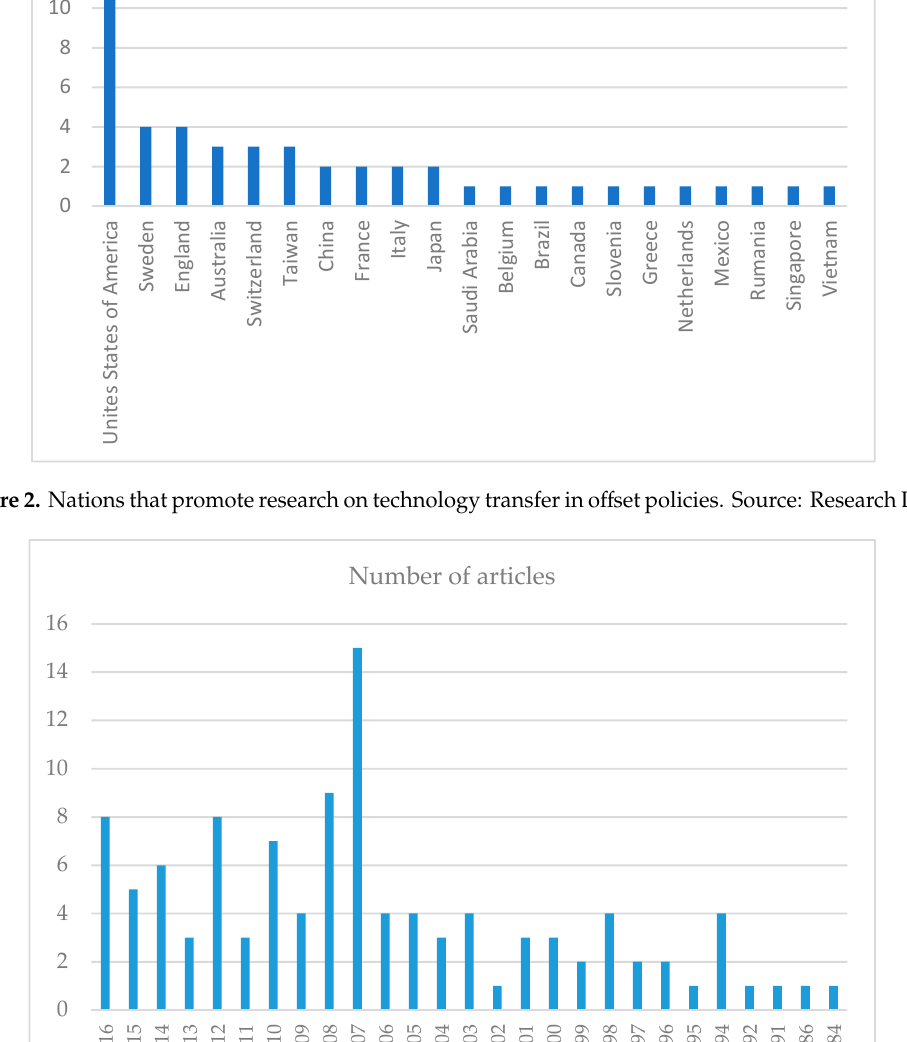
Figure 3. Respective years of publication of articles. Period: “AllYears”. Source: Research Data.